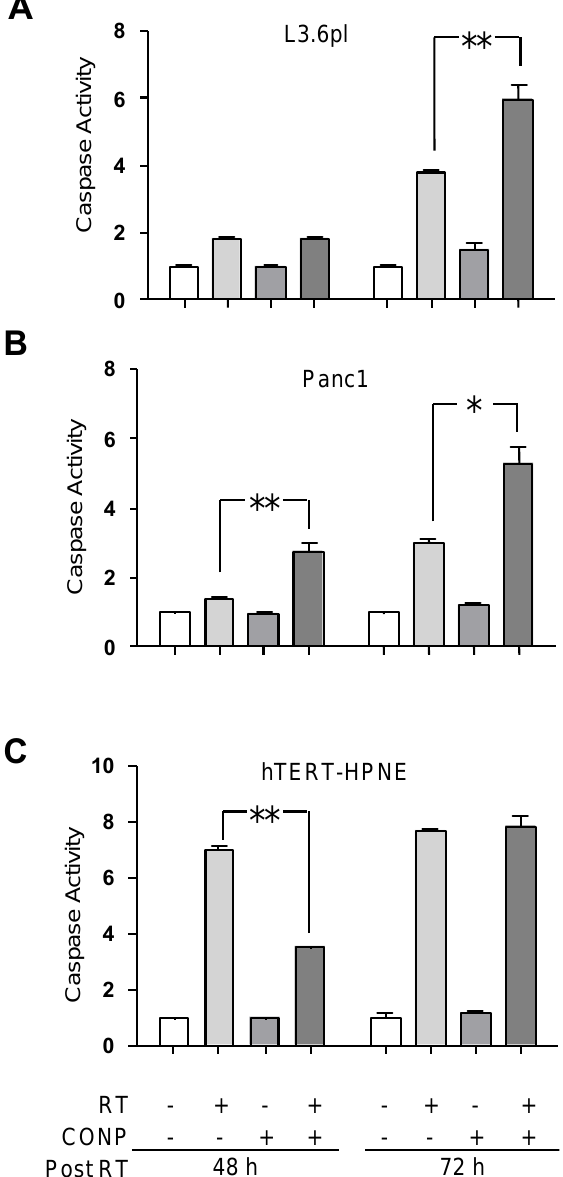
Figure 3. CONP Treatment Drives RT-induced Apoptotic Caspases Activation in Pancreatic Cancer Cells but Not Normal Cells in vitro . L3.6pl ( A ), Panc1( B ) and hTERT-HPNE ( C ) cells were treated with or without 10 µ M CONPs for 24 h followed by exposure to 0 or 5 Gy RT. Caspase 3/7 activation